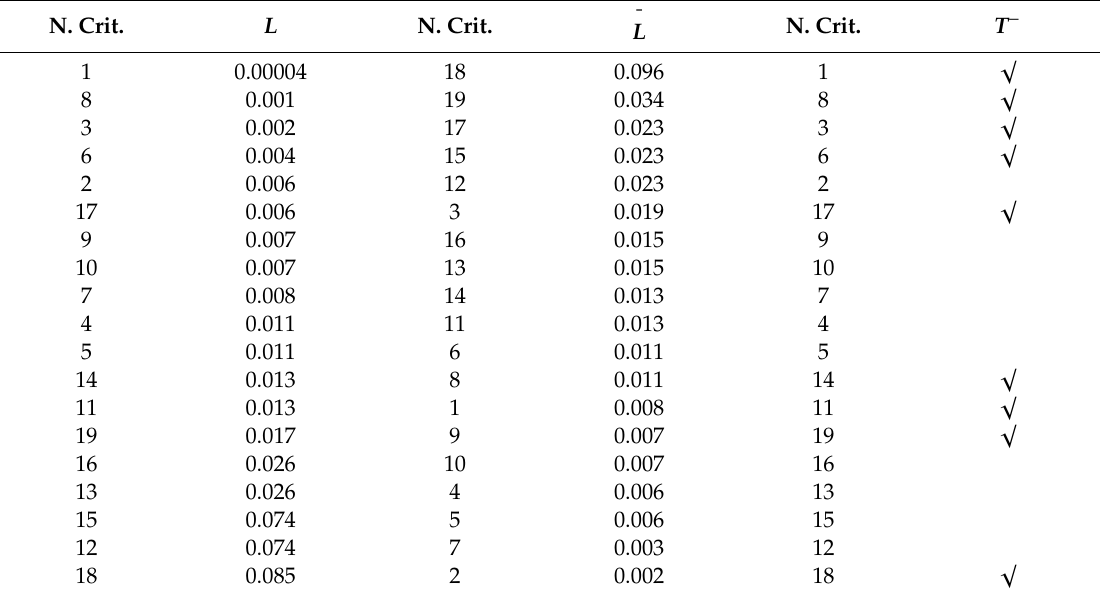
Table 9. Lists if L, L, T + , and T − for ϑ = 1.